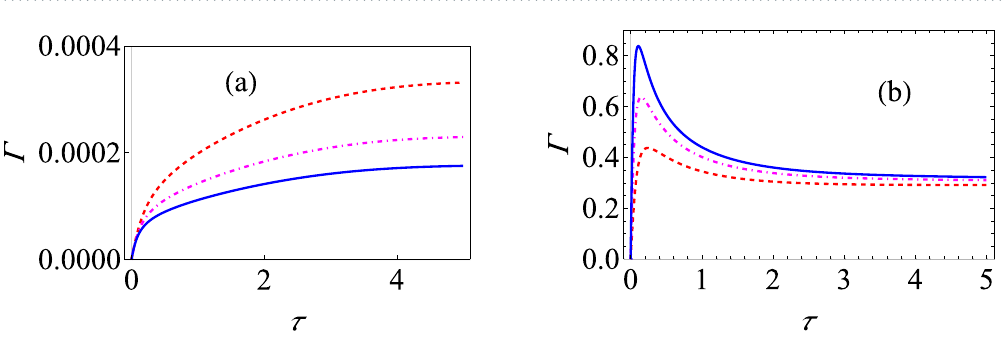
Figure 1. Variation of the effective decay rate with change in system-environment coupling strength. ( a ) Graph of Γ (at zero temperature) for the strong-coupling regime as a function of τ with the system-environment coupling strength G = 1 (red, dashed curve), G = 1.75 (dot-dashed, magenta curve), and G = 2.5 (solid, blue curve). Here we have used an Ohmic environment ( s = 1), with ε = 1, ω c = 10, and Δ = 0.05. The initial state is | ↑ 〉 . ( b ) Behaviour of Γ (at zero temperature) for the usual weak system-environment coupling scenario leading to only population decay for G = 0.02 (dashed, red curve), G = 0.05 (dot-dashed, magenta curve), and G = 0.1 (solid, blue curve). Here we have used again an Ohmic environment, the initial state is still | ↑ 〉 , ε = 1, and = 10. Throughout, we use dimensionless units with  = 1 . ω c